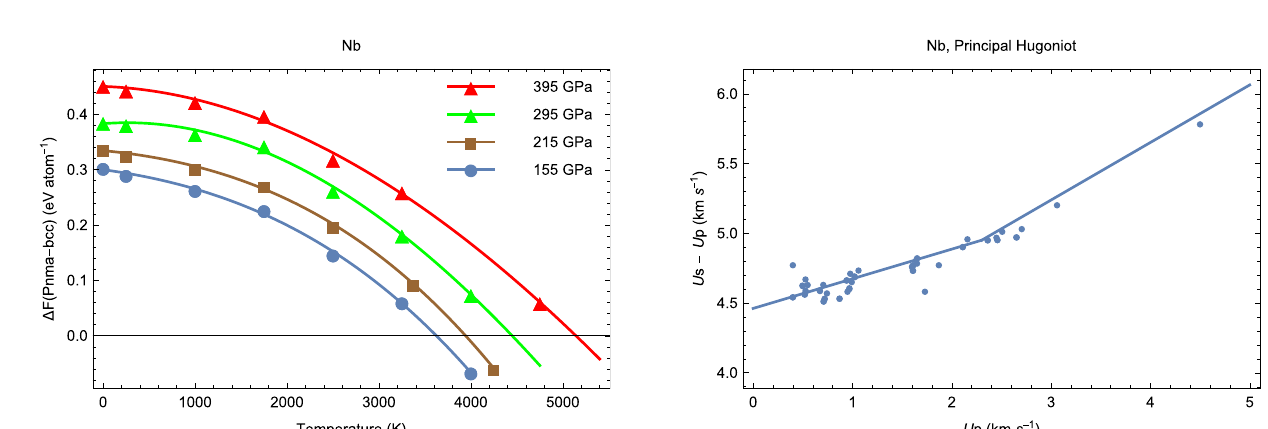
Fig. 5. This formulation is valid up to ~60 GPa; at higher P , σ = σ ( P ) fl attens out 52,53 , so that σ / P ≪ 1 and Δ F ≪ F means that the line of fast resrystallization gets very close to the